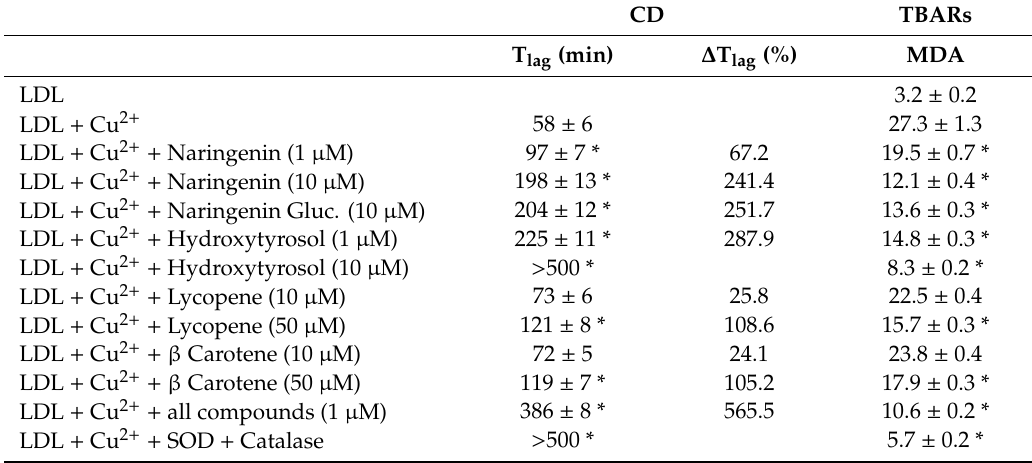
Table 1. E ff ect of sofrito bioactive compounds of on Cu 2 + mediated oxidation of low-density lipoproteins LDL, which was monitored by conjugated dienes (CD) and thiobarbituric acid reactive substances (TBARs) formation. T lag was the di ff erence in lag phase (min) between Cu 2 + and Cu 2 + plus tested of LDL protein. Superoxide dismutase (SOD) (30 µ M) and catalase (50 µ M) were used as positive control. Results are expressed as means ± SEM of two experiments performed in triplicate. * Significantly di ff erent from Cu 2 + without treatments.